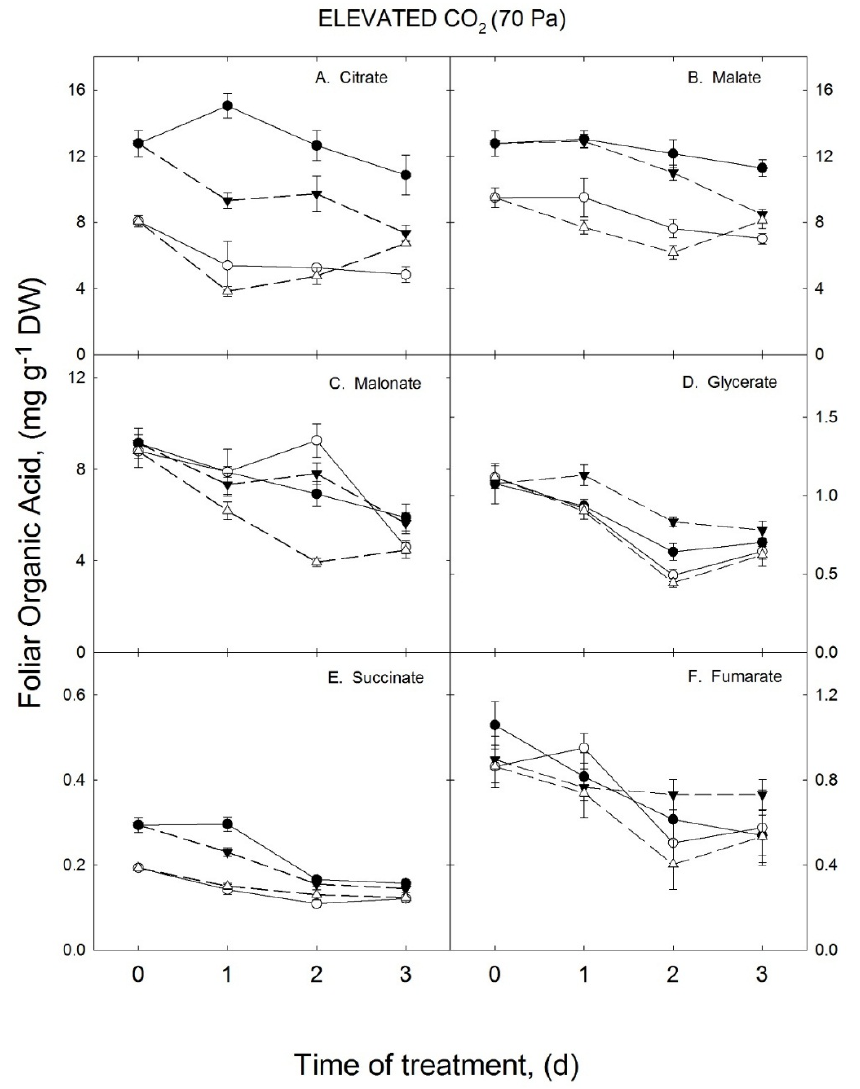
Figure 2. Effects of reciprocal changes of growth temperature on concentrations of organic acids in soybean leaflets under elevated CO 2 (70 Pa). Experimental details and symbols were as in Figure